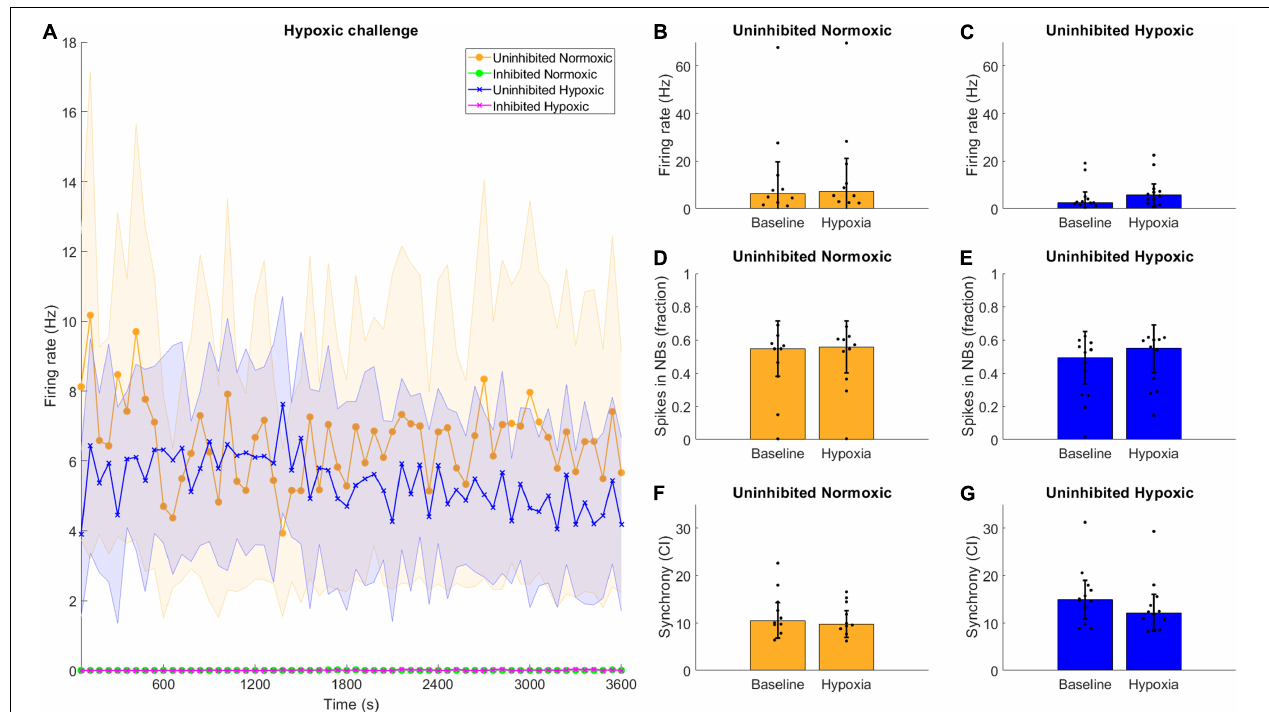
FIGURE 5 | Hypoxic challenge and GABA inhibition. The hypoxia exposed, uninhibited networks showed similar activity to uninhibited networks normoxic networks, while inhibited networks were completely silenced. (A) Data during the hypoxia session was divided into 1-min bins and is shown here throughout the 1-h recording. Uninhibited networks showed stable activity throughout the episode, while inhibited networks were completely silenced. Lines and shaded regions indicate median ± median absolute deviation. (B–G) There were no significant differences between the baseline electrophysiological activity and the activity during the hypoxic exposure in terms of firing rate, burst propensity or synchrony, for normoxic controls or hypoxic networks, assessed by Wilcoxon rank sum test, all p > 0.05. Bars and error bars indicate median ± median absolute